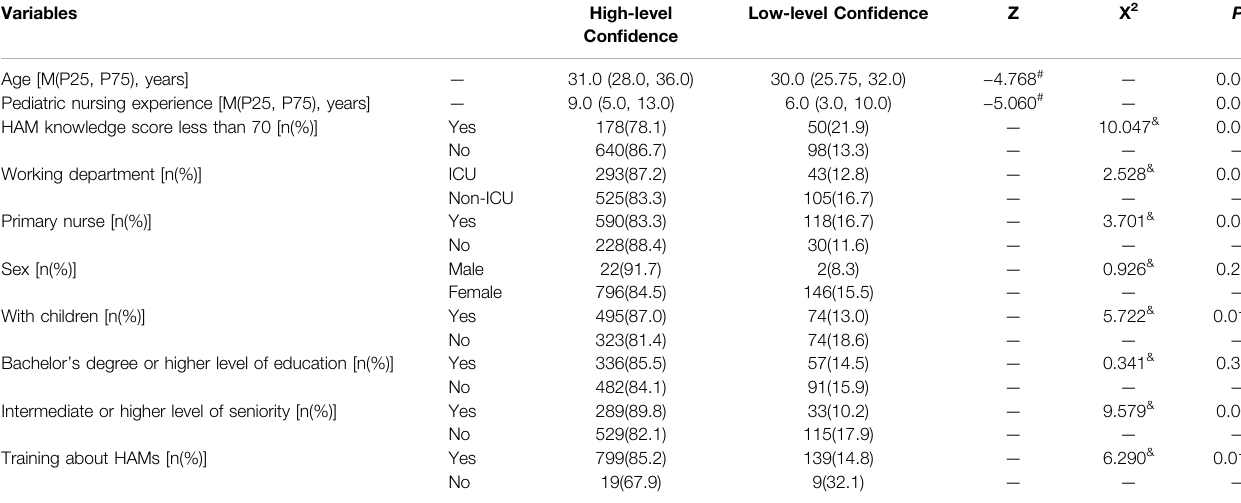
TABLE 3 | Level of con fi dence of decision-making ( N = 966). Variables